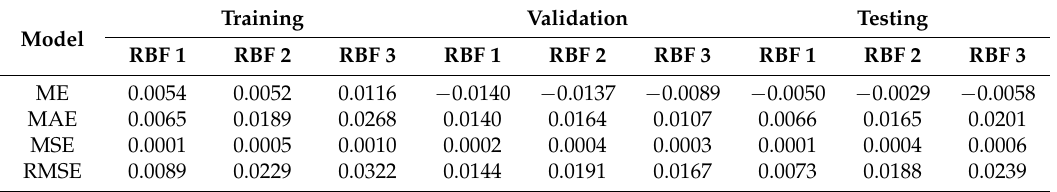
Table 12. Statistical analysis of the different RBF models in the training, validation and testing